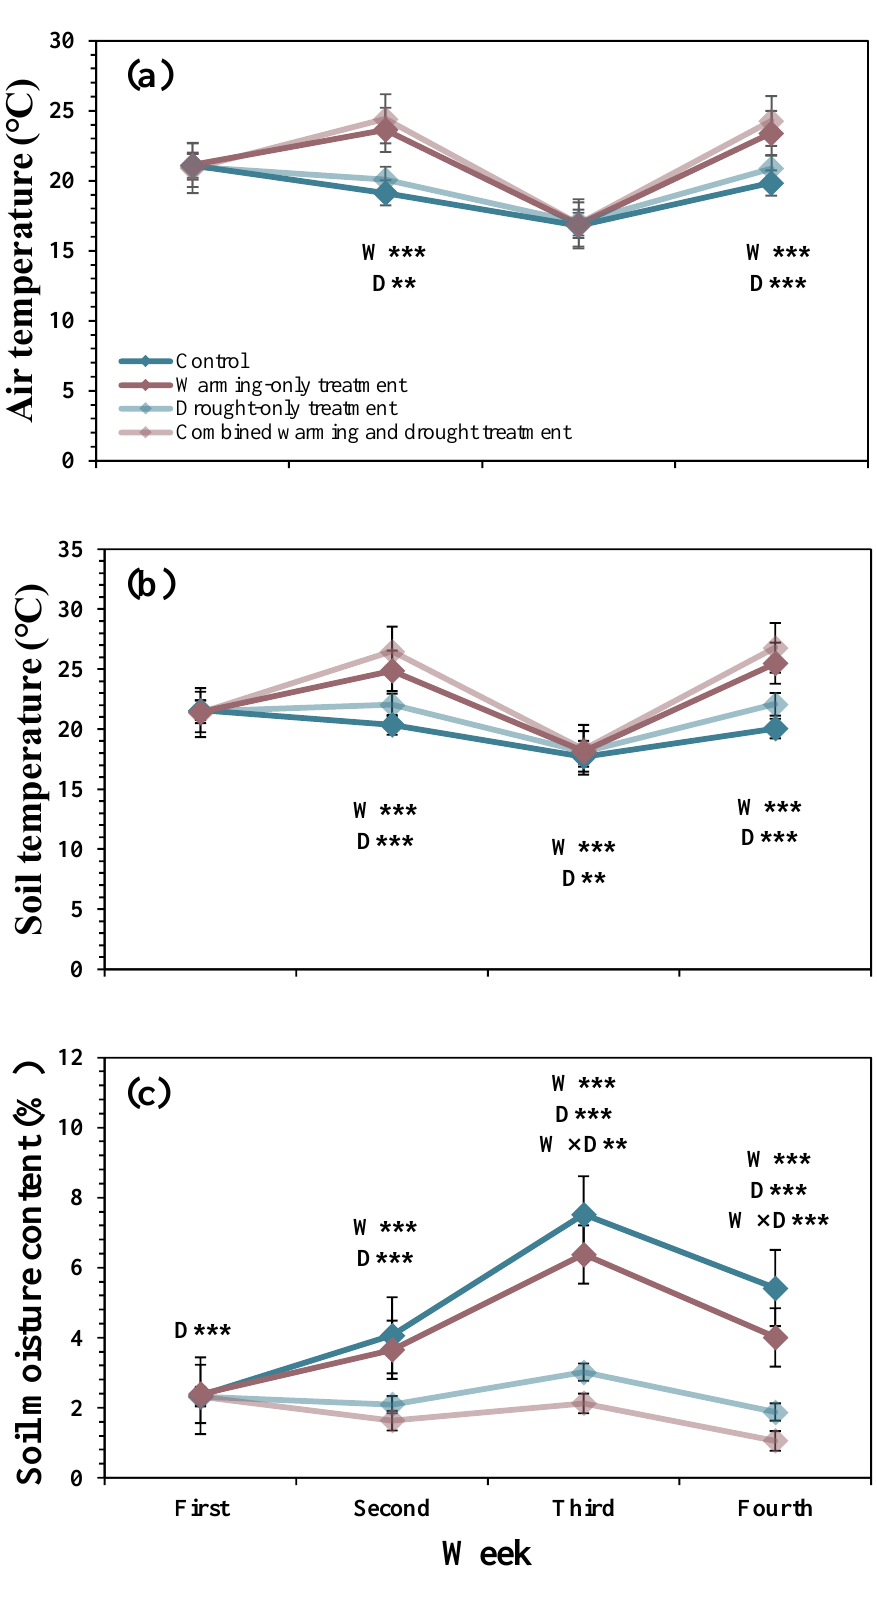
Figure 2. Mean weekly changes in air temperature ( a ), soil temperature ( b ), and soil moisture content ( c ) in May 2020. Error bars are the standard errors of the means, and asterisks (*) indicate significant differences between the warming and drought treatments (** p < 0.01; *** p < 0.001). W: warming effect; D: drought effect; W × D: interaction effect of warming and